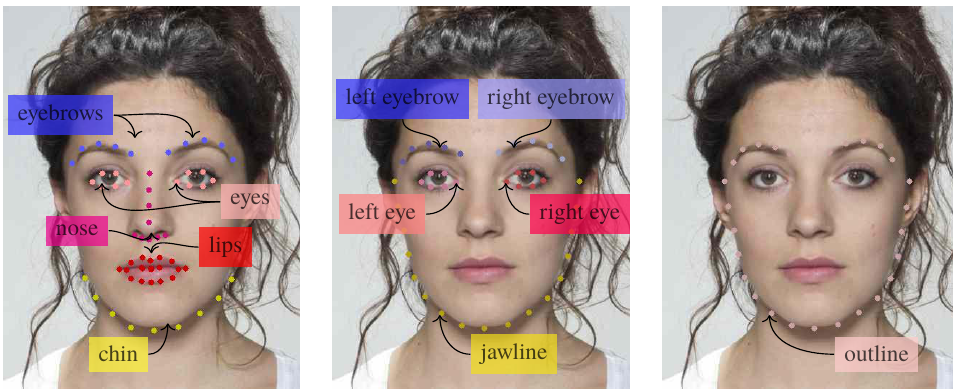
Figure 9. Landmark groups for our ablation study.